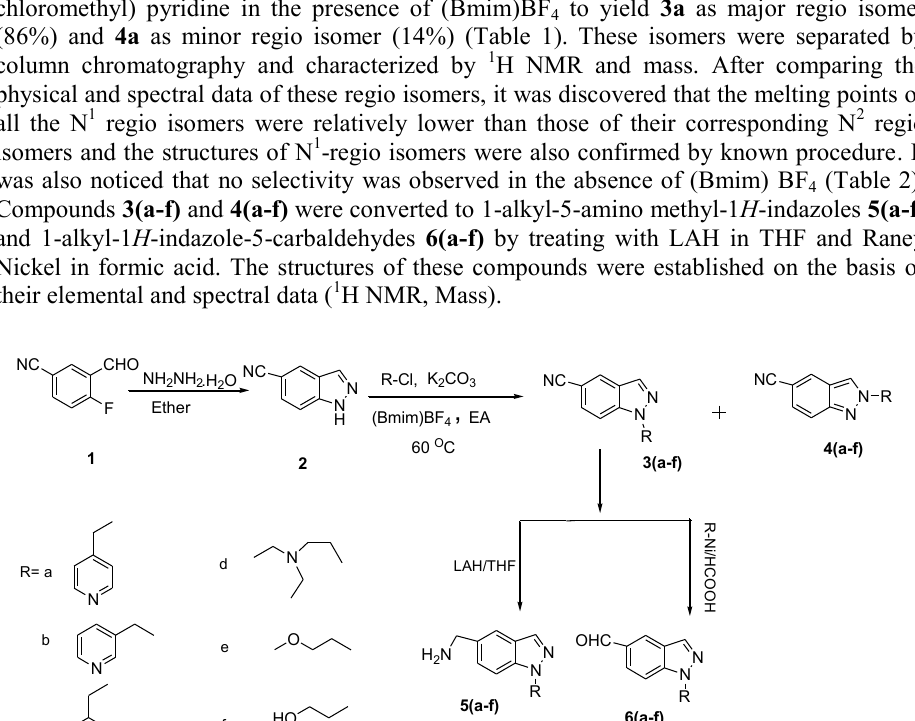
ionic liquid as phase transfer catalyst. 4